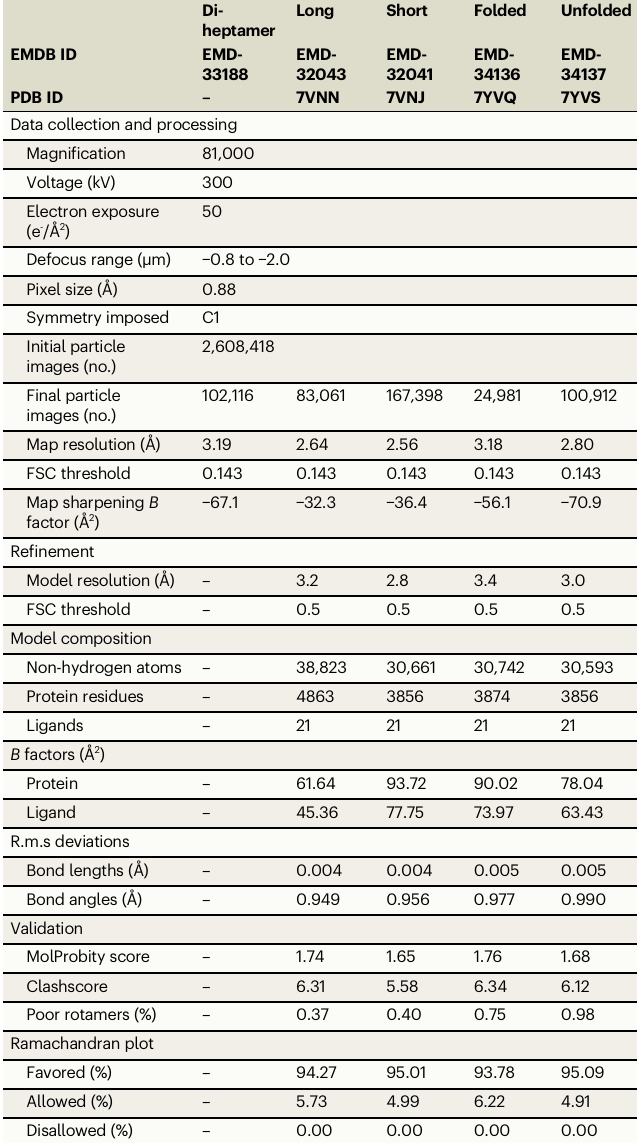
Table containing detailsofcryo-EM datacollection, processing,andre fi nementincluding relevant statisticsforall mapsand models